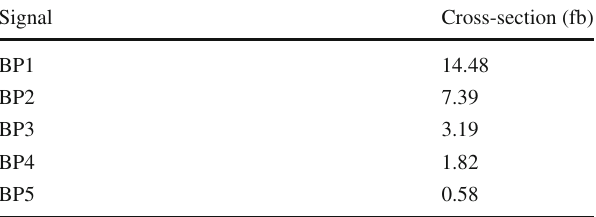
Table 9 The LO cross-sections for the signal pp → 2 (cid:3) + E T /